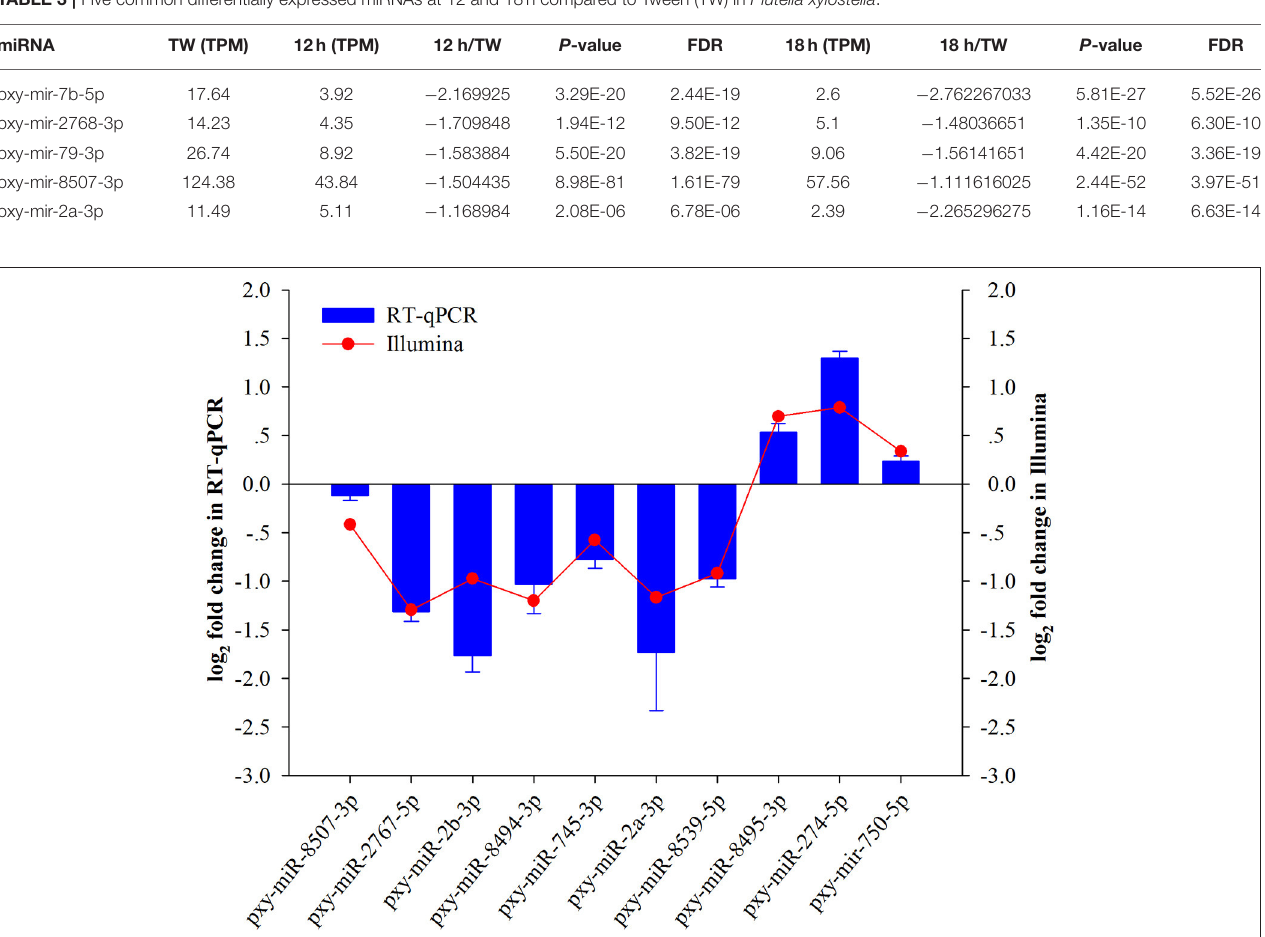
FIGURE 3 | Validation of expression of ten miRNAs achieved by RT-qPCR and sRNA-Seq in Plutella xylostella after Isaria. fumosorosea infection. Error bars represent ± SD from three independent experiments. U6 snRNA was used as an internal control.